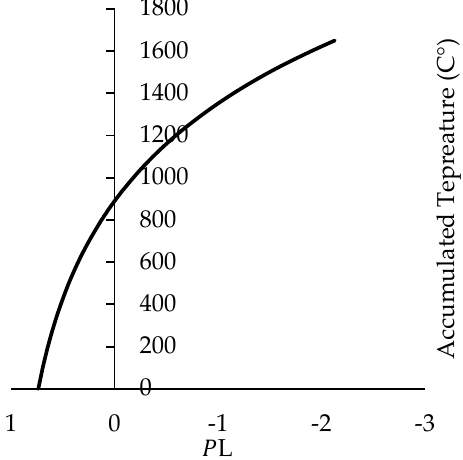
Figure 14. Relationship between 𝑃 (cid:3013) and the accumulated temperature.